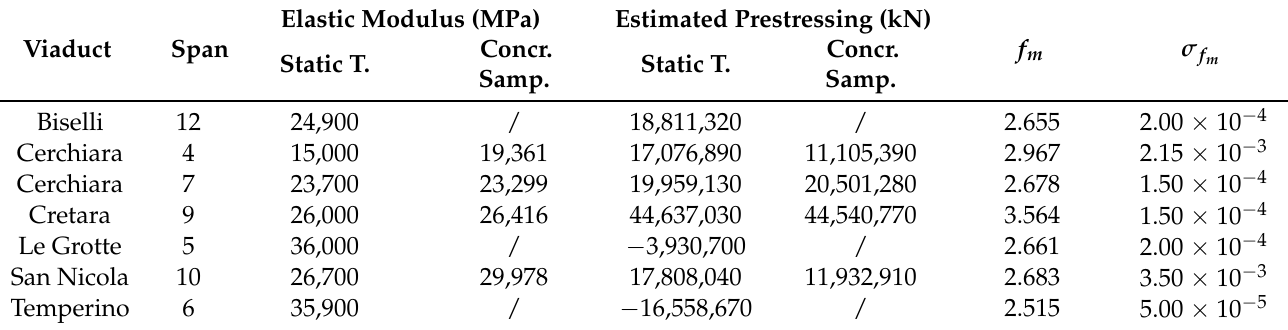
Table 2. Outcomes of the experimental tests on the prestressed concrete girders. Static T. stands for static test, Concr. Samp. stands for concrete samples.